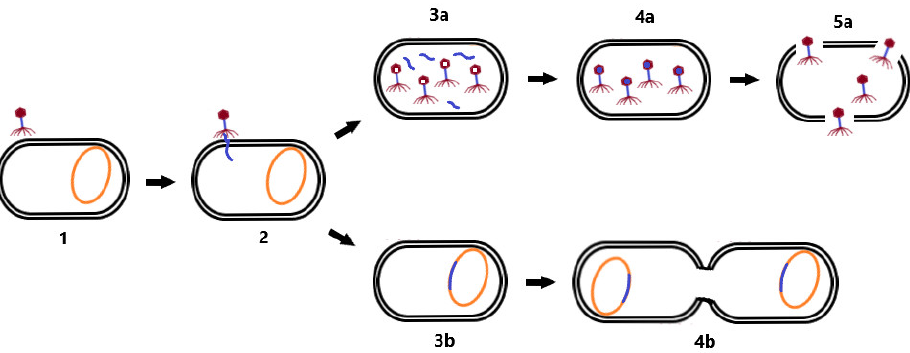
Figure 1. Life cycle of bacteriophages. First, the phage adsorbs to the bacterial cell receptor ( 1 ). Second, it forms a pore in the membrane and phage NA is injected into the host cell ( 2 ). As the virus continues the lytic cycle, viral proteins are produced, phage NA ( 3a ) replicates, and virion assembly ( 4a ) and cell lysis ( 5a ) occur. During the lysogenic cycle, the phage integrates its genome into the host chromosome ( 3b ) and replicates with it ( 4b ). Changing conditions may induce a transition to the lytic cycle.